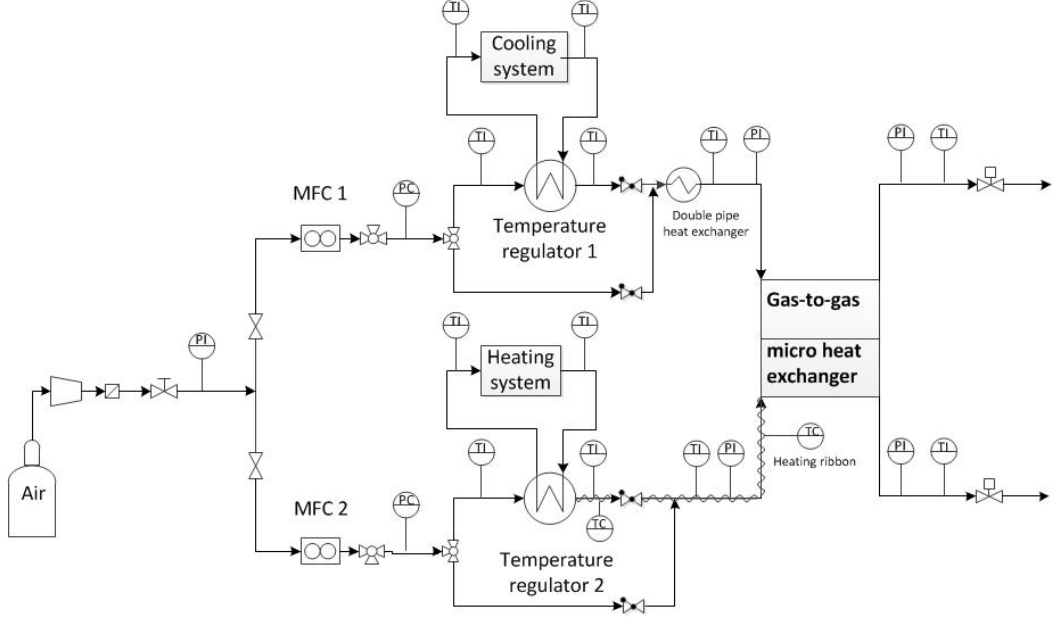
Figure 3. Schematic view of the experimental setup for the investigations with